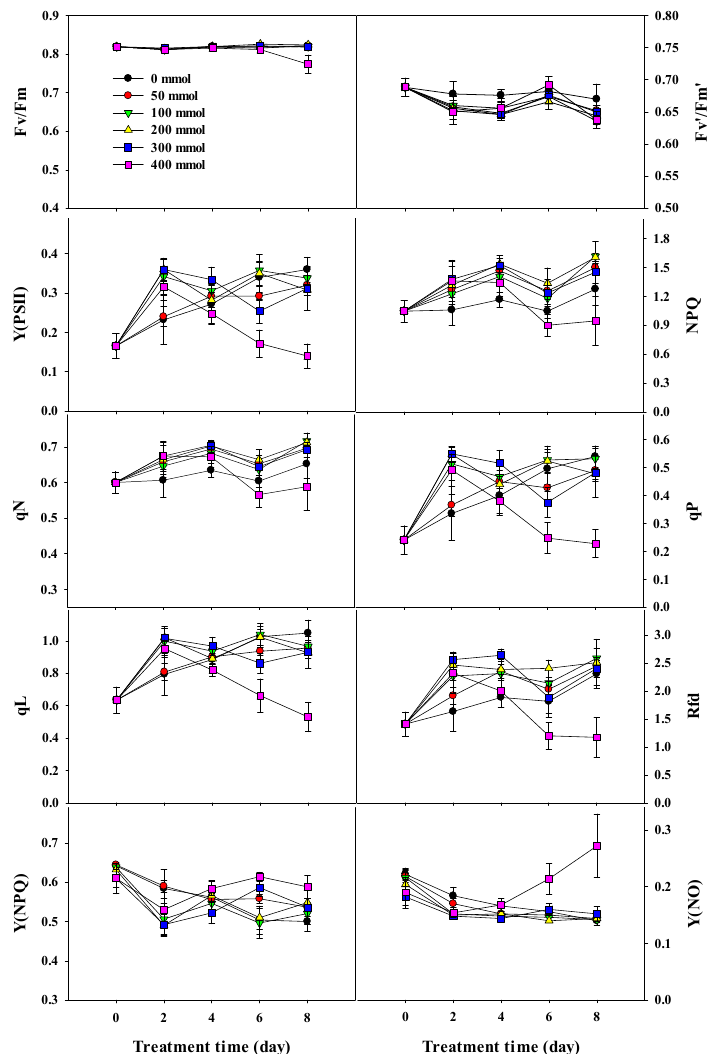
Figure 2. Changes in the chlorophyll fluorescence (CF) parameters in the seedlings of lettuce grown under different NaCl concentrations during different time period. Each plot point represents the mean ± SD of five biological replicates. Description of each CF parameter is presented in Table 1.